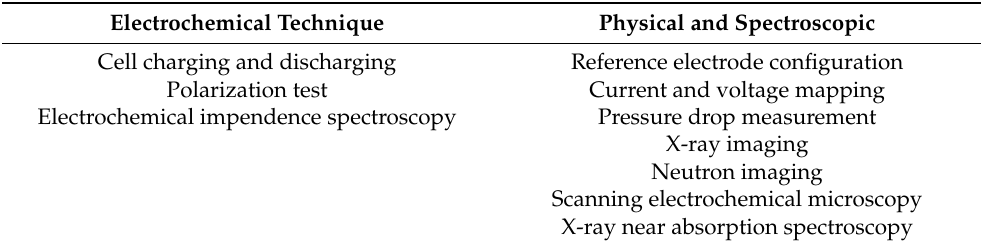
Table 1. In situ diagnostic tools used in VRFBs.